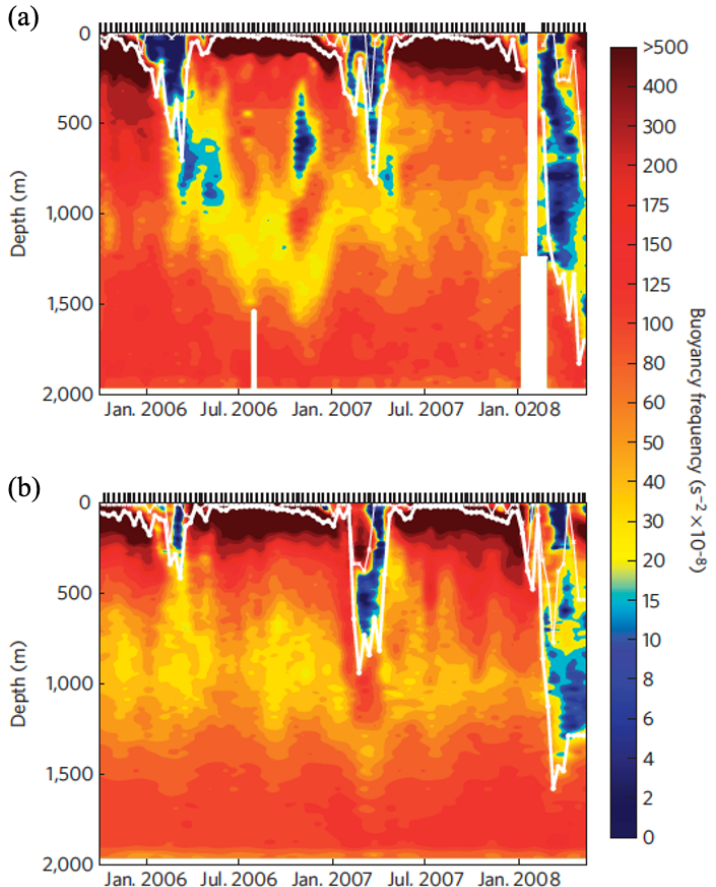
Figure 4. The squared buoyancy frequency for two Argo floats in ( a ) the Labrador Sea and ( b ) south of Greenland for the time period 2006–2008. The white line shows the mixed layer depth and the vertical lines at the top of the figures show the timing for each vertical profile. Reproduced with permission from Våge et al. [59], published by Springer Nature